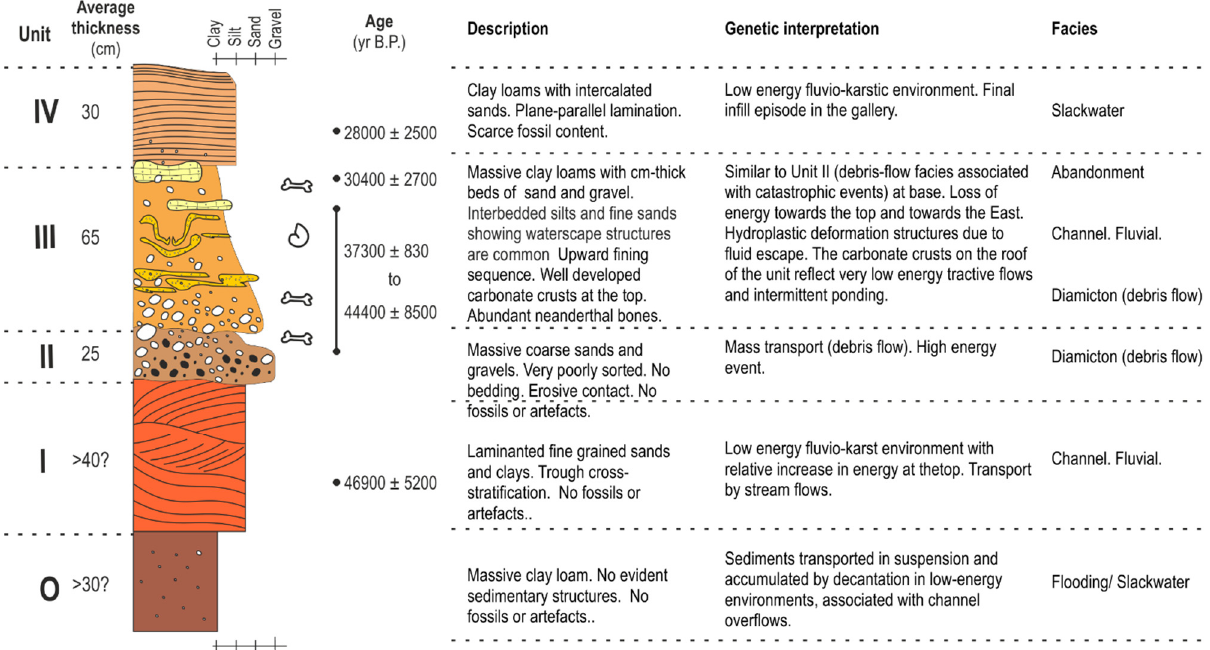
Figure 2. Stratigraphic column from the central zone of the Ossuary Gallery (Sector 3), with a brief description of the main sedimentary units and their genetic interpretation. Modified from Cañaveras et al. [16,18].